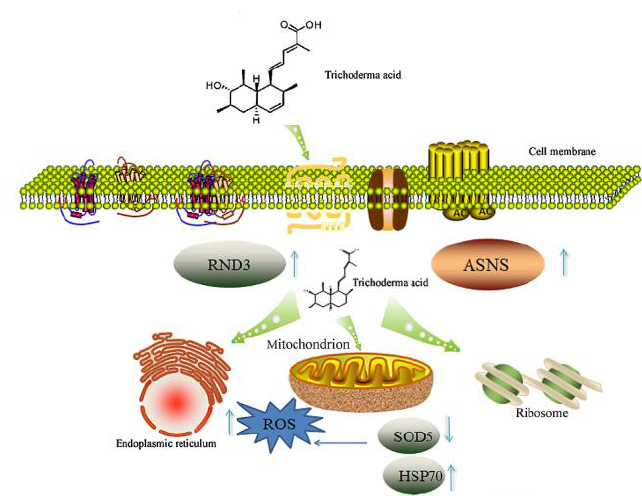
Figure 7. The proposed action mechanism of TA towards C. albicans. The network of 79 significantly differentially expressed proteins between the CK and TA-8 groups with changes of more than 1.2-fold and less than 0.85-fold was constructed using the software STRING 11.5 (Figure S4). The differentially expressed proteins were divided into three clusters. In the red cluster, CaO19.2788, which refers to adaptins that are assumed to interact with membrane proteins and CEK2 proteins; CDC24, which refers to the MAPK pathway protein Rho protein; and YCF1, which refers to the ATP-binding cassette glutathione S-conjugate transporter, showed the highest number of nodes with other proteins. These results suggested the important role of the MAPK pathway and